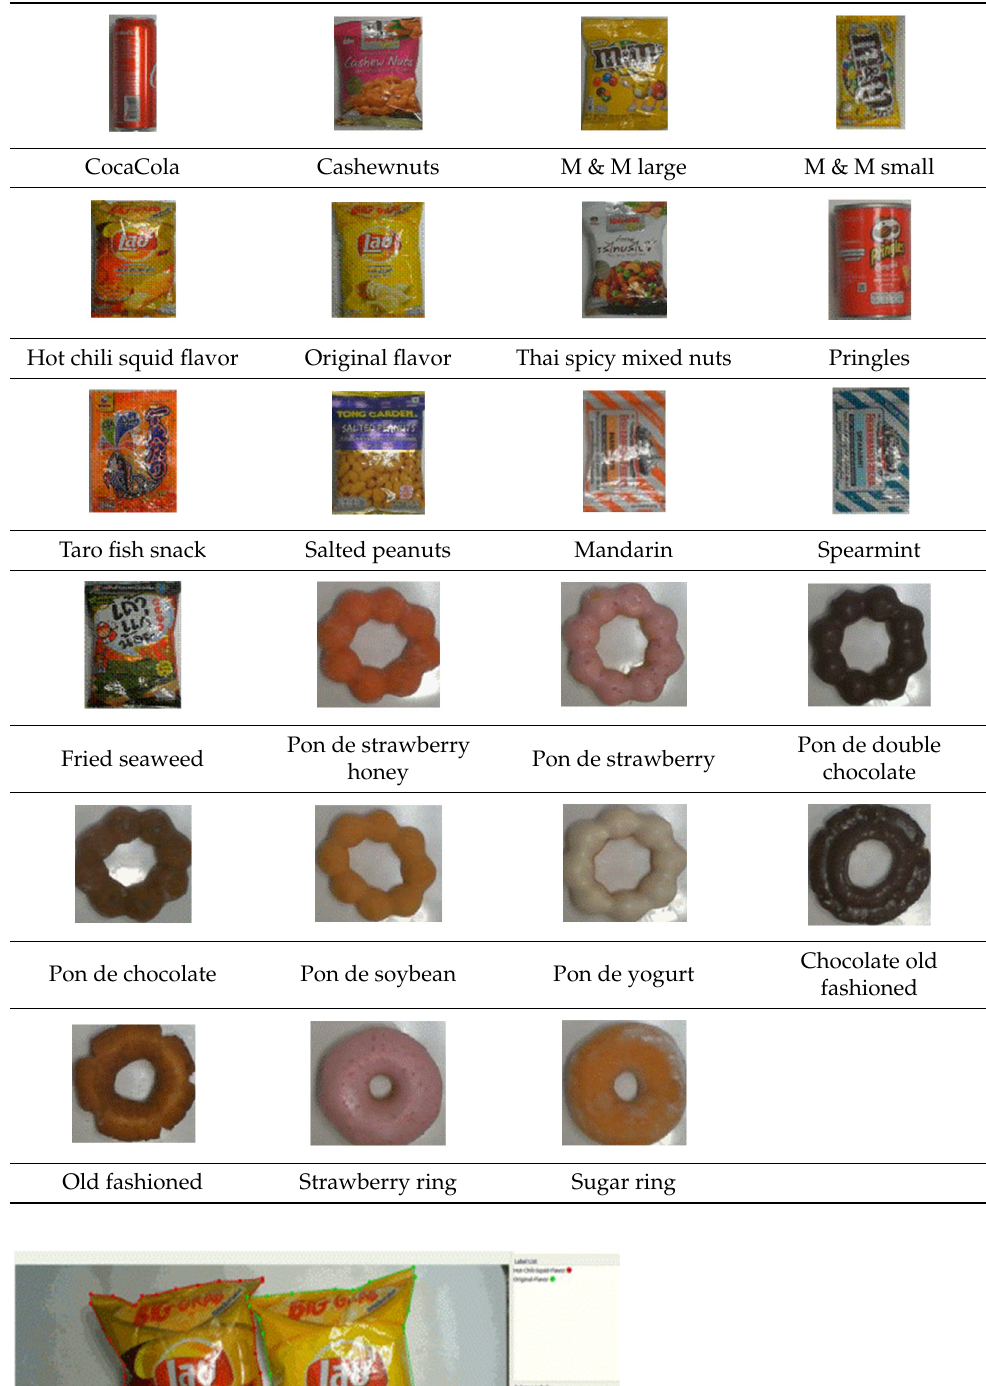
Figure 7. Marking objects with Labelme. Table 2. Items in the Snacks database.